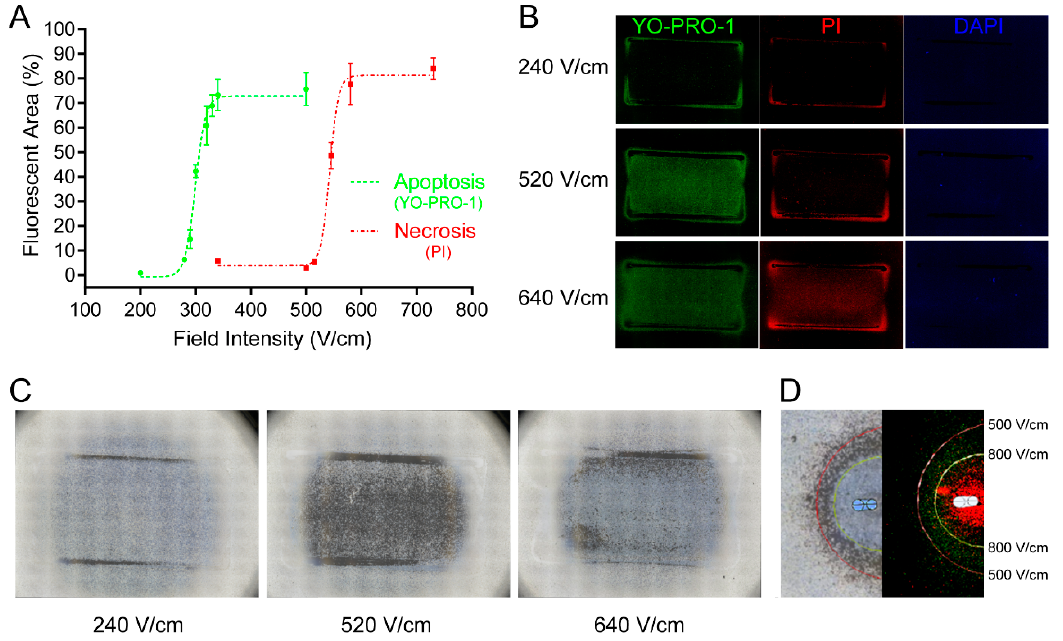
Figure 1. Electroporation-induced apoptosis and necrosis were determined by field intensity. ( A ) Field intensity of electroporation influenced the percentages of green (apoptosis) and red (necrosis) fluorescent areas to the entire treated area in a dose–effect-related manner. The threshold field intensity of electroporation-induced apoptosis and necrosis was approximately 270 V/cm and 520 V/cm, respectively. ( B ) Representative fluorescence images of unaffected (green and red fluorescence double negative), apoptotic (green fluorescence single positive), and necrotic cells (green and red fluorescence double positive) are presented. Nuclei of all cells were visualized using DAPI staining (blue fluorescence). ( C ) Corresponding representative light microscopy pictures of unaffected (240 V/cm), apoptotic (520 V/cm), and necrotic cells (640 V/cm) were acquired 24 h after electropo- ration. ( D ) Similar fluorescence after electroporation (right part) and corresponding morphological changes 24 h afterwards (Left part) were reproduced by the flat non-uniform electric fields generated by two parallel-needle electrodes. Solid red and yellow lines are numerical simulations of rough apoptotic and necrotic threshold field intensity (500 V/cm for the red line and 800 V/cm for the yellow line). Perspective blue and white cylinders represent one of the parallel-needle